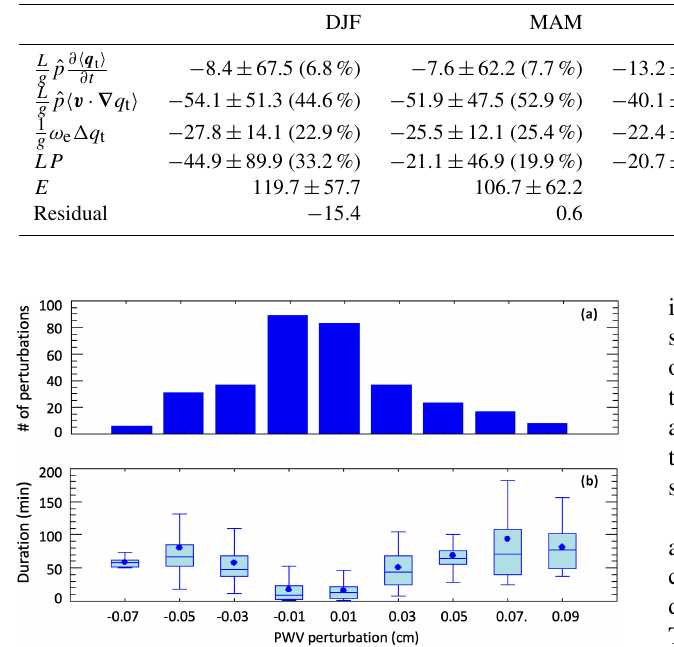
Figure 6. (a) Distribution of the 345 water vapor perturbations found in the 10d analyzed. (b) Duration of water vapor perturba- tions binned by the amplitude of the perturbation: N = 6, 31, 37, 89, 83, 37, 23, 17, and 8 for a total of 331 points. The 14 missing cases are distributed in the bins below − 0 . 07cm and above 0.09cm with fewer than five points in each bin. A duration of ∼ 30min cor- responds to a wind speed of 5ms − 1 , and a duration of 50min cor- responds to a wind speed of ∼ 3ms − 1